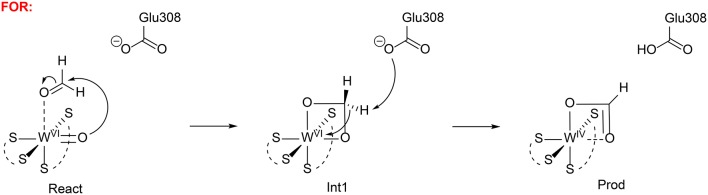
Suggested mechanisms for FOR (Liao et al., 2011b). Copyright (2011) Elsevier Inc.